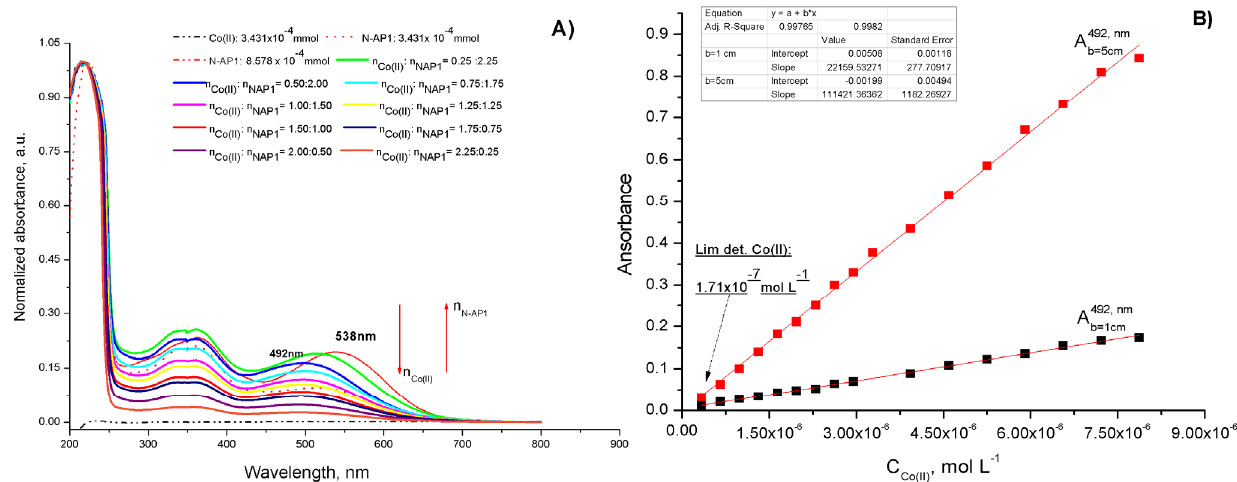
Figure 6. ( A ) Absorption spectra of solutions containing Co (II) and ligand: N-AMP1(L1) with different molar fractions of the two binding agents; ( B ) study of the dependence of A = f(C Co (II), mol L − 1 ) on solutions containing twice the amount of excess ligand.